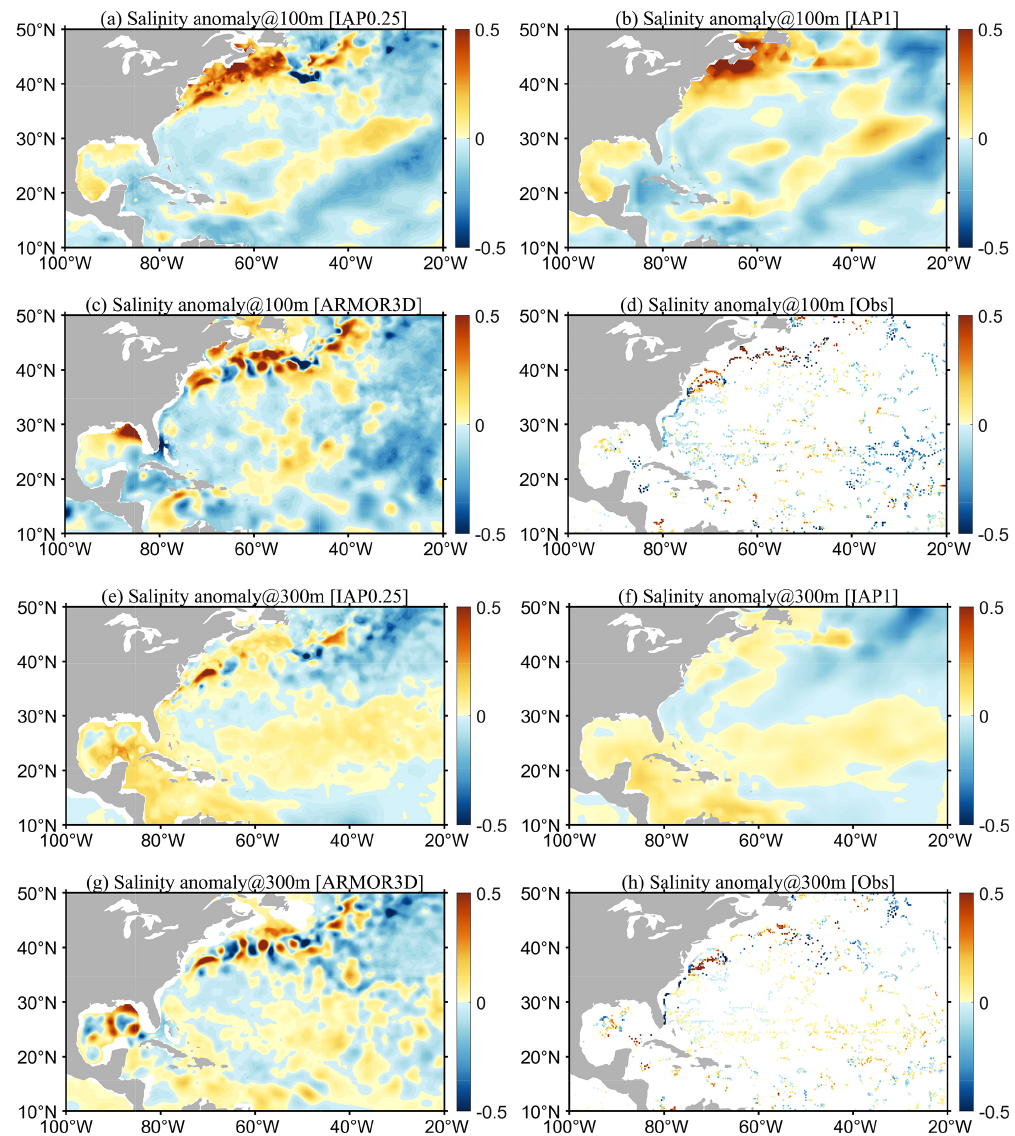
Figure 5. The geographical distribution of salinity anomalies in the Gulf Stream region for IAP0.25 ◦ , IAP1 ◦ , ARMOR3D, and in situ observations in January 2016: (a–d) 100m and (e–f) 300m.